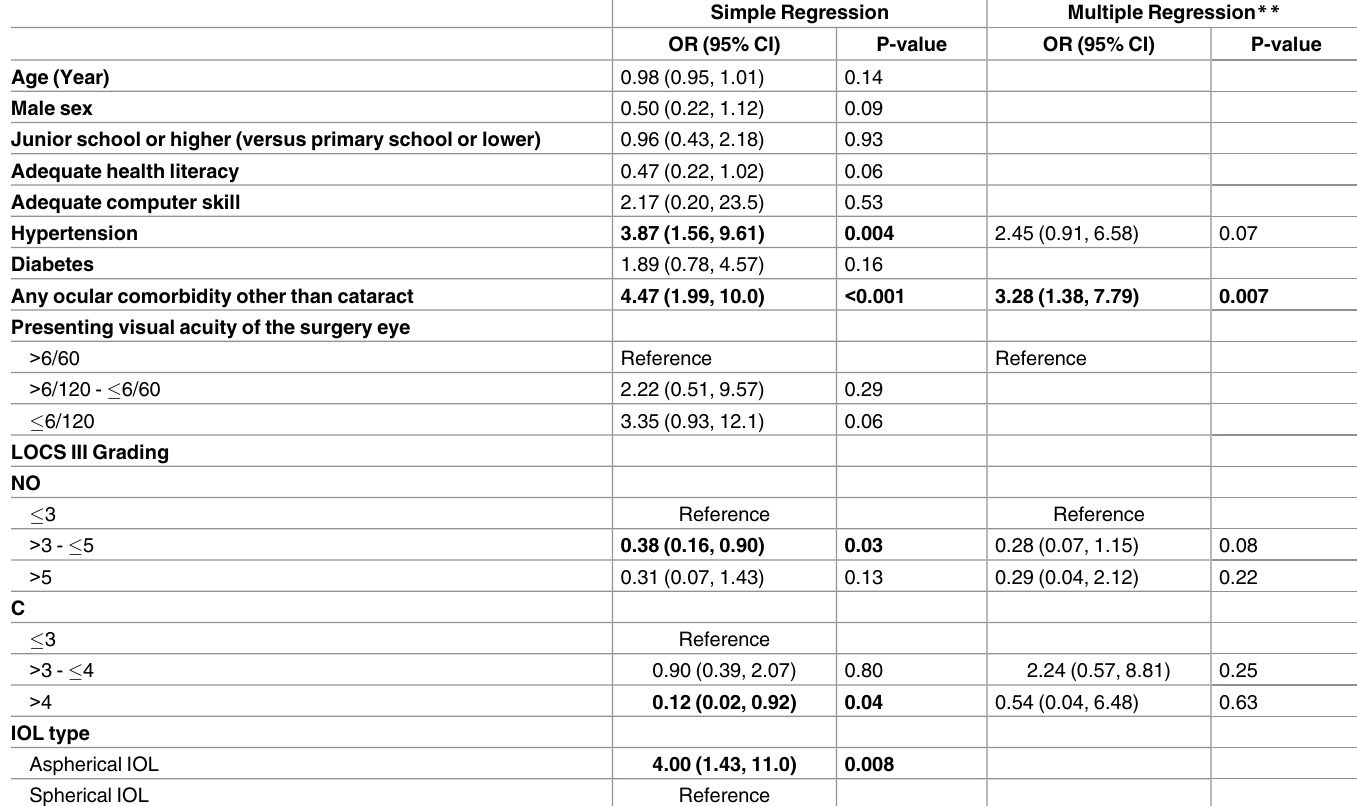
Table 7. Ordinal logistic regression of potential predictors of the satisfaction with the surgery * (N = 172).